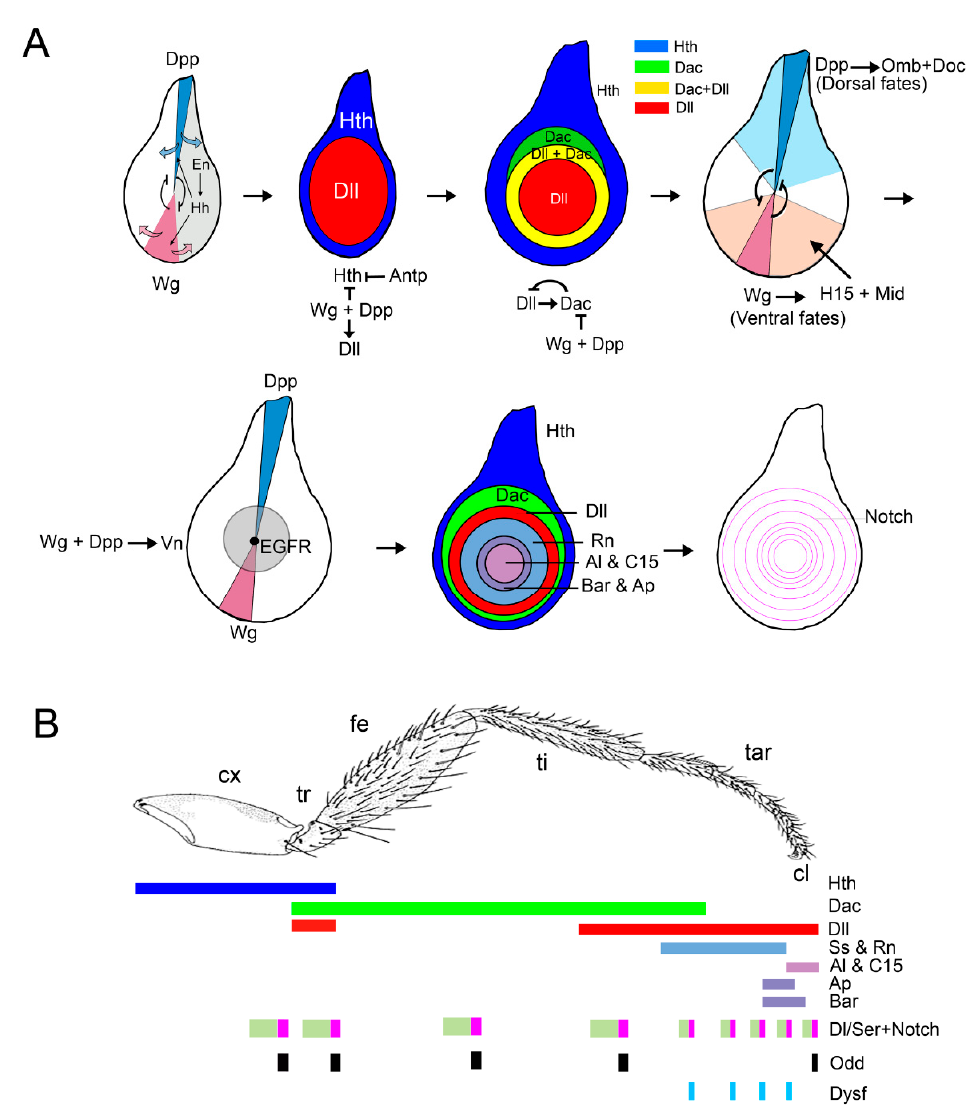
Figure 2. Patterning of the Drosophila leg. ( A ) Overview of the proximo-distal (P-D) and dorso-ventral (D-V) axes formation during leg development. The restricted expression of dpp and wg in the dorsal and ventral halves of the leg disc is required to initiate and to pattern the P-D and D-V axes. The first two leg imaginal discs from the left correspond to early second instar discs, while the rest depict third instar leg discs. Some of the genetic interactions that lead to the leg patterning are indicated. ( B ) The ‘genetic code’ generated by the expression of several transcription factors specify the future segments of the adult leg along the P-D axis. The expression of the Notch ligands Dl and Ser , and the activation of the Notch pathway and its target genes is necessary for the formation of the joints that separate the adjacent segments of the leg.